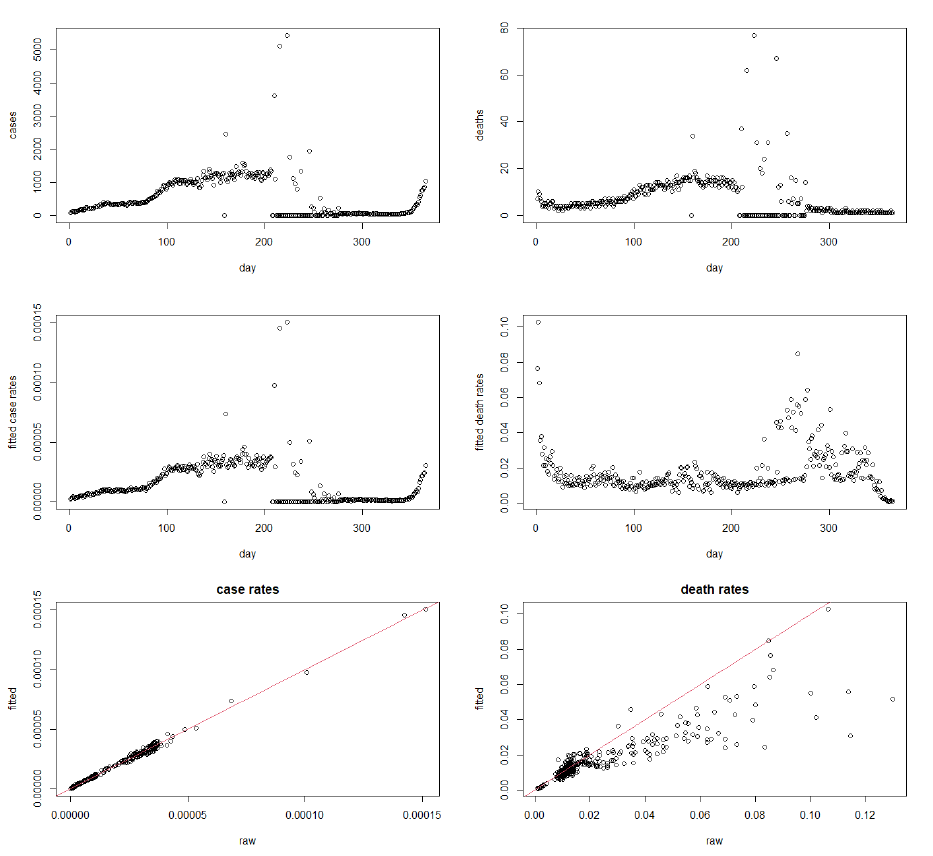
Figure 2. Top : daily COVID-19 cases ( left ) and deaths ( right ) in Saudi Arabia in 2021; middle : fitted daily COVID-19 rates ( left ) and death rates ( right ) in Saudi Arabia in 2021; bottom : fitted versus raw case rates ( left ) and death rates ( right ) in Saudi Arabia in